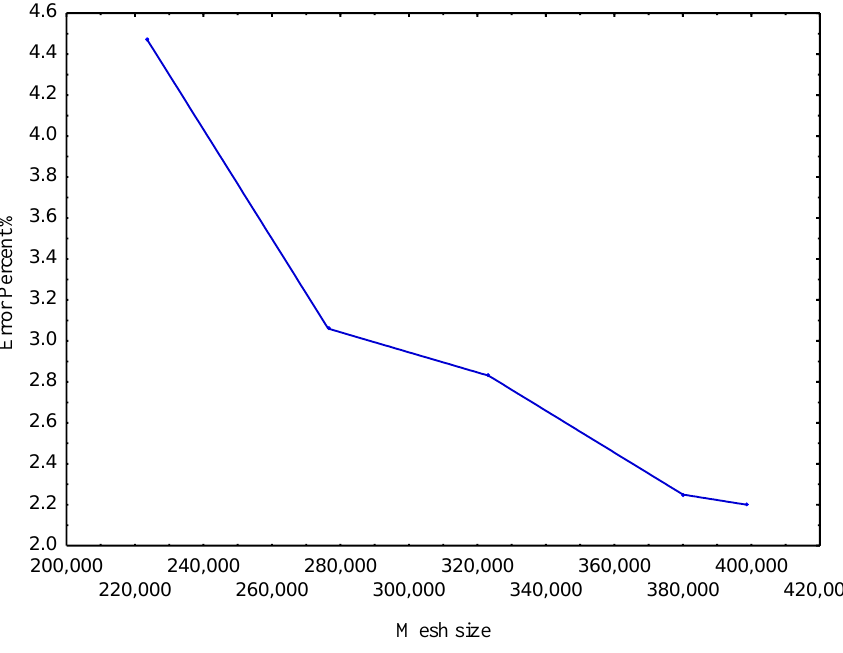
Figure 4. The mesh